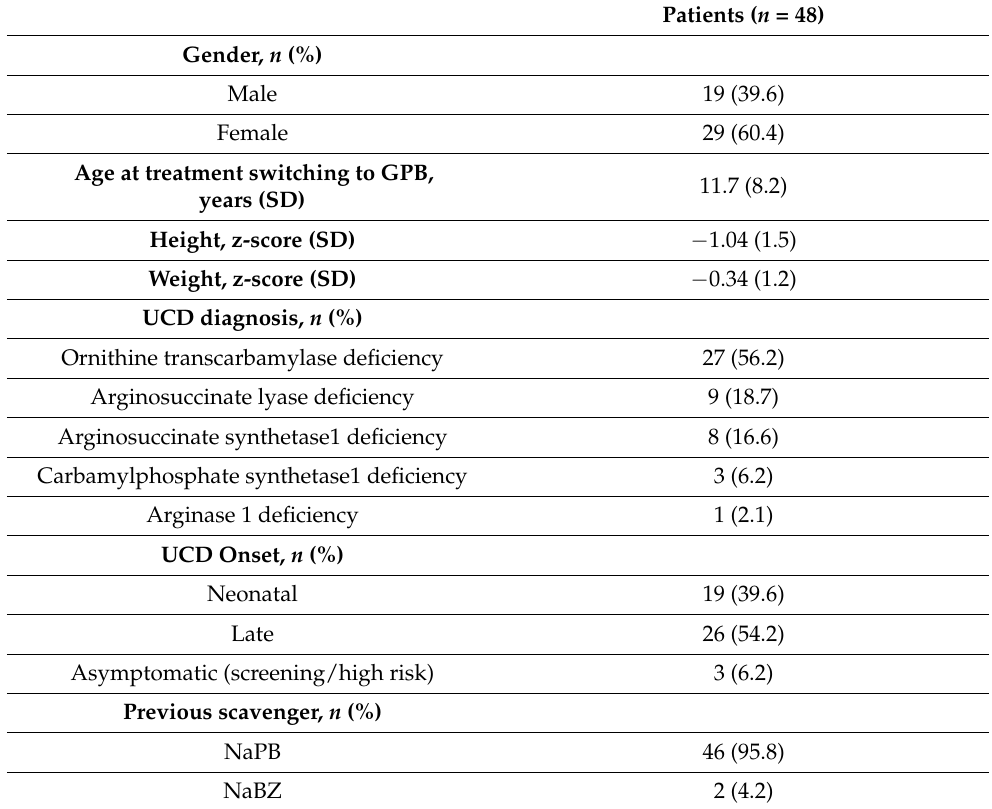
Table 1. Demographic and clinical data at